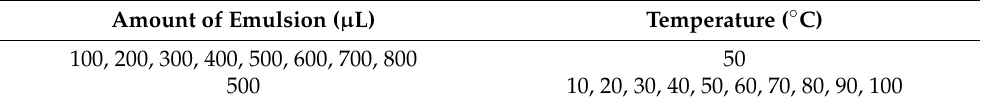
Table 1. Variable table for the single-factor experiment of PSt microspheres self-assembly on a wood